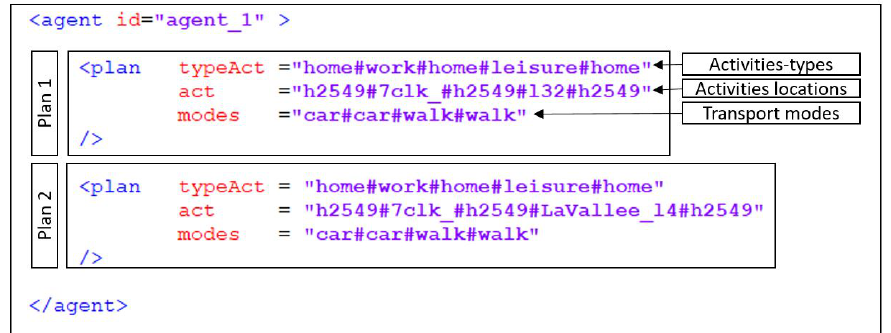
Figure 11. Agent activity-plans: agent _1 has two plans, both of which have the same sequence of activities, the sequence of used transport modes, home and work locations; however, they differ in the location of leisure ( l 32 for the first plan and LaVallee _ l 4 for the second plan).